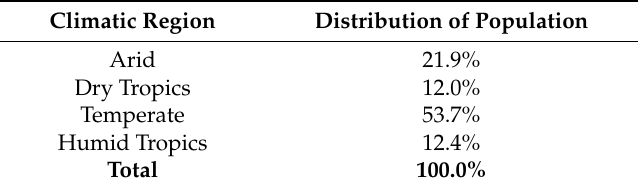
Table 1. Number of air-conditioned dwellings gathered by climatic region. Climatic Region